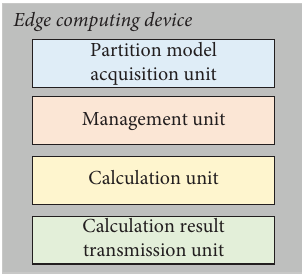
Figure 4: Edge computing